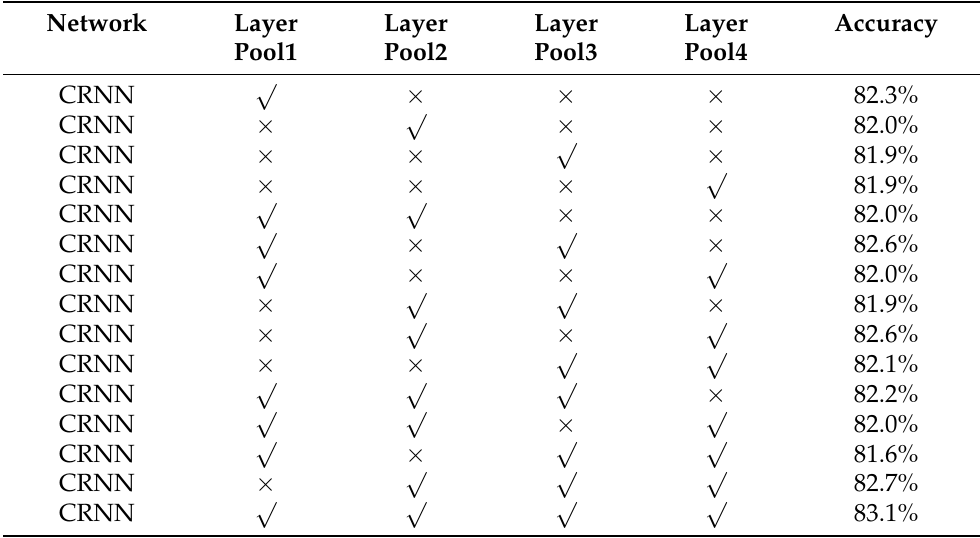
Table 6. Classification accuracy comparison for different TFAM allocations.